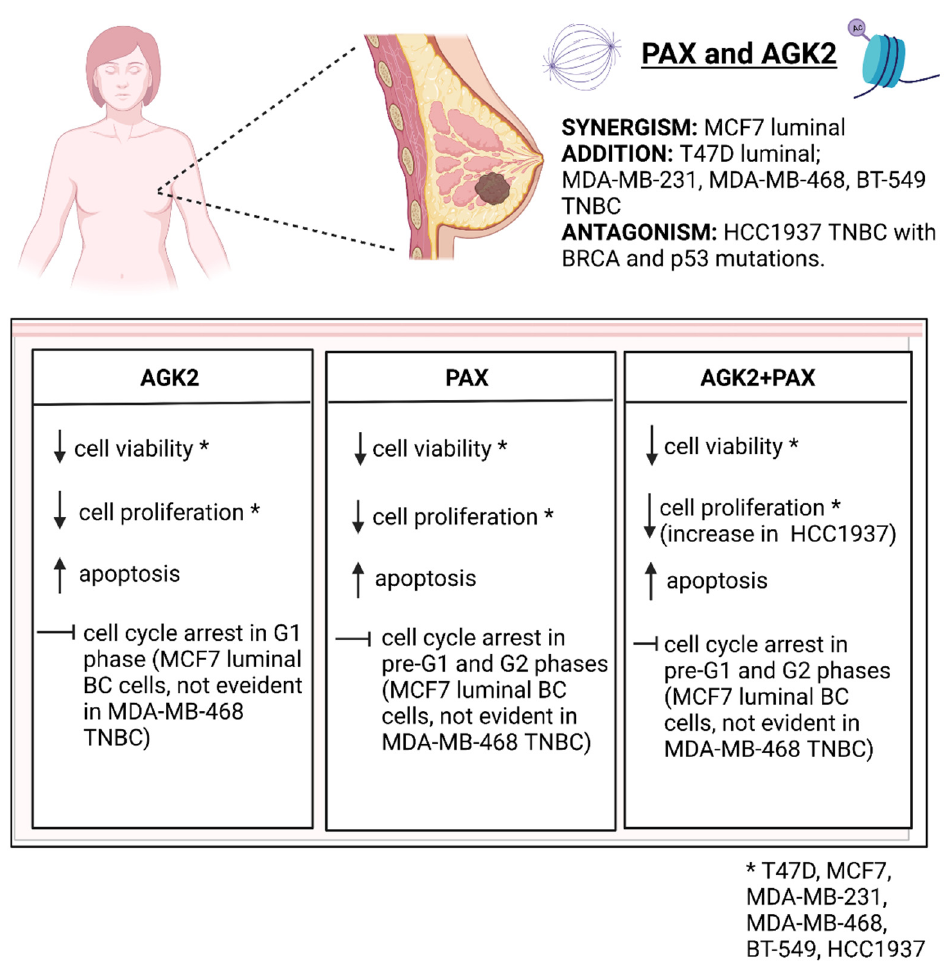
Figure 20. Summary of the PAX/AGK2 activity in the T47D, MCF7, MDA-MB-231, MDA-MB-468, BT-549, HCC1937 breast cancer (BC) cells (decrease; increase; TNBC—triple-negative breast cancer). Created with www.biorender.com (accessed on 31 March 2022).